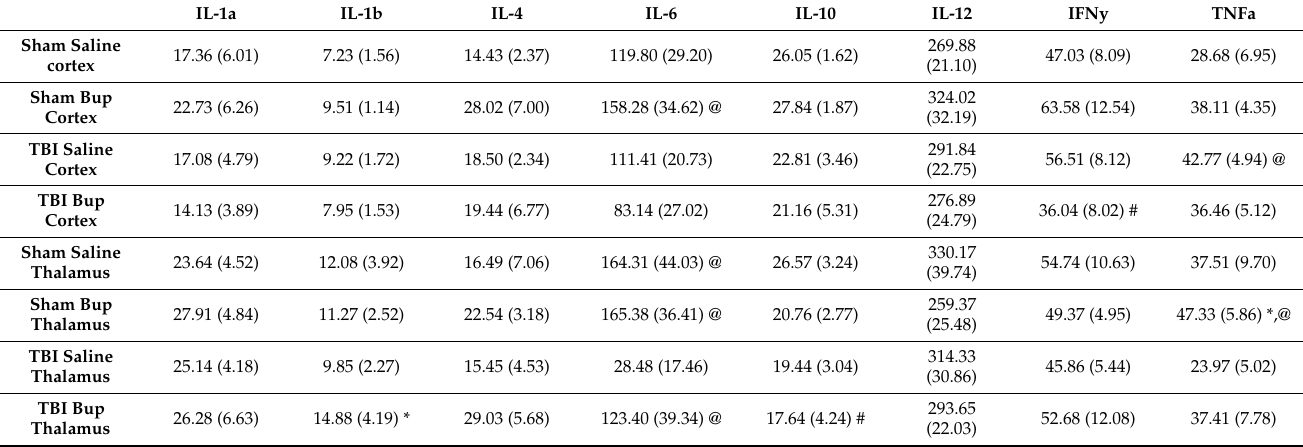
Data presented as mean (Standard Error of the Mean). * p < 0.05 compared to Sham Saline Cortex; # p < 0.05 compared to Sham Bup-SR-Lab Cortex; @ p < 0.05 compared to cFPI Saline